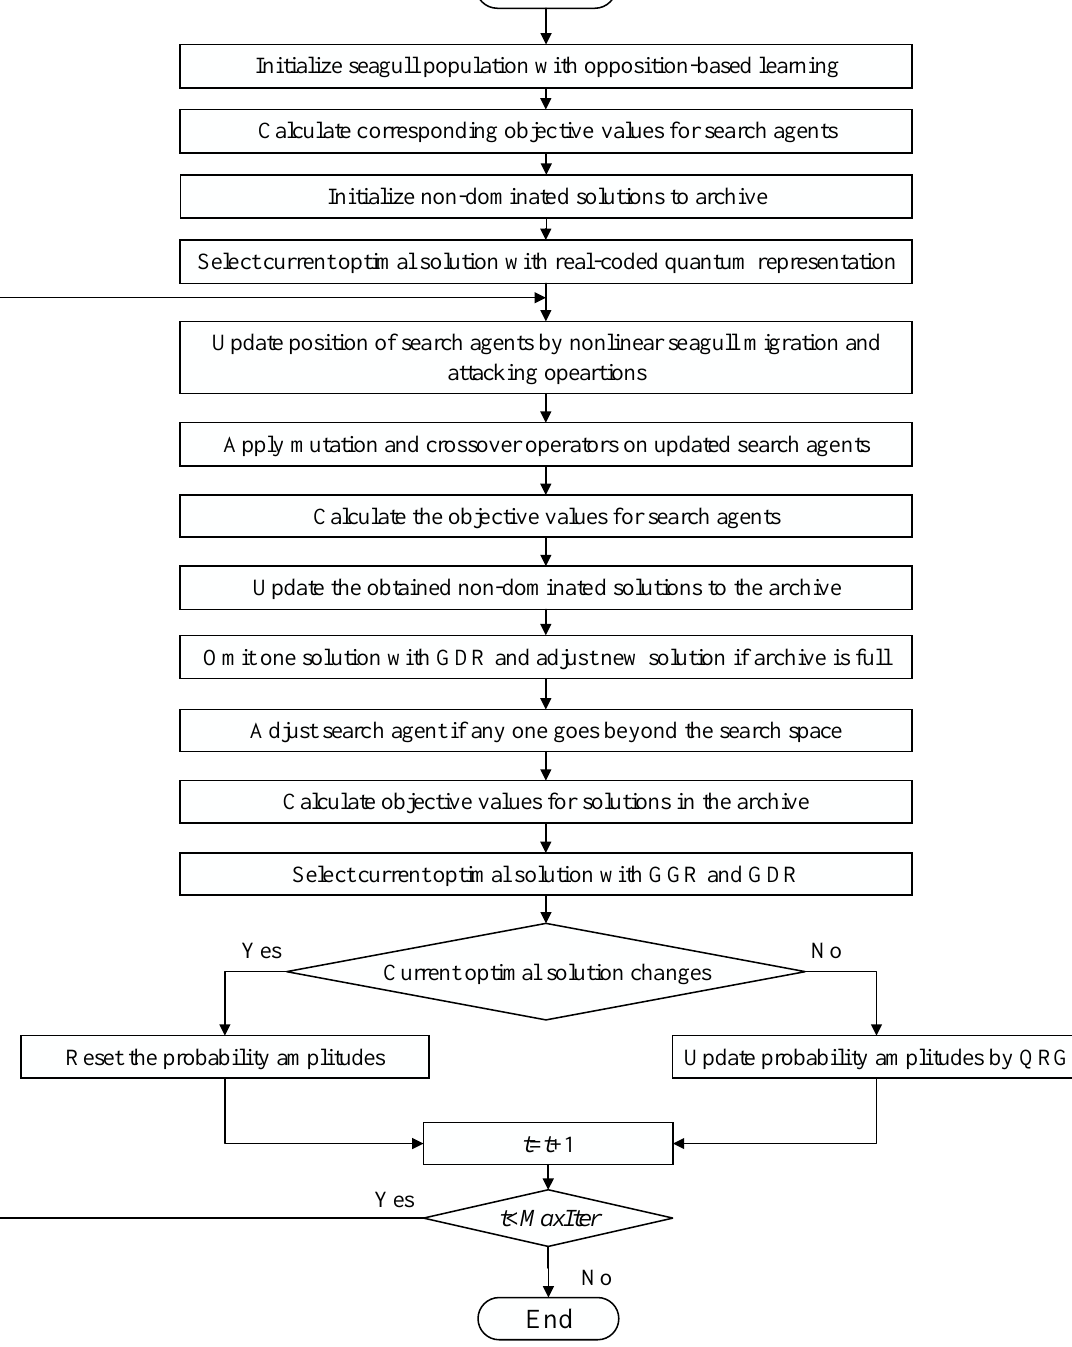
Figure 1. Framework of MOQSOA.